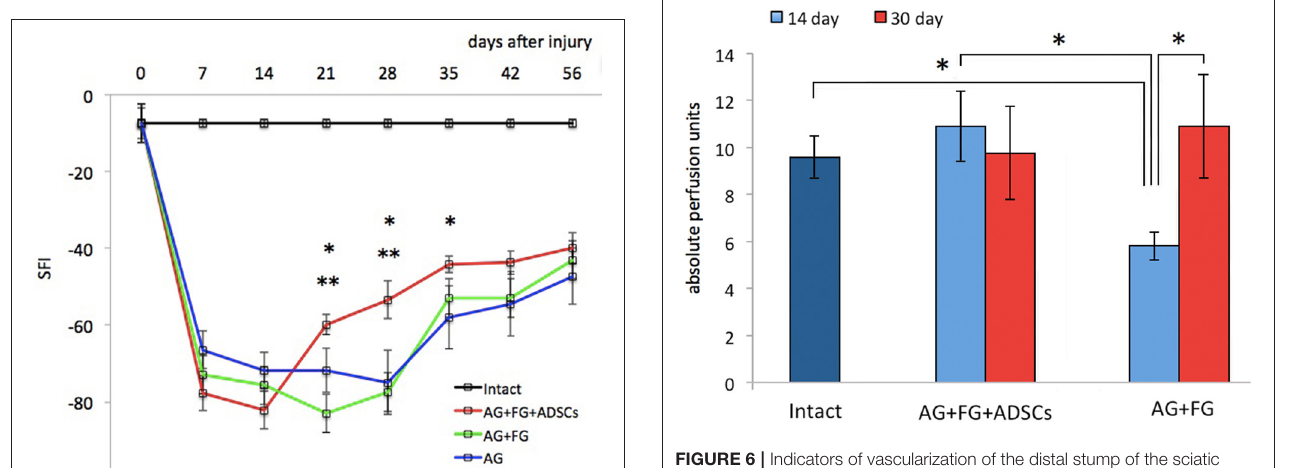
ADSCs with fibrin glue significantly improved the described degenerative changes.